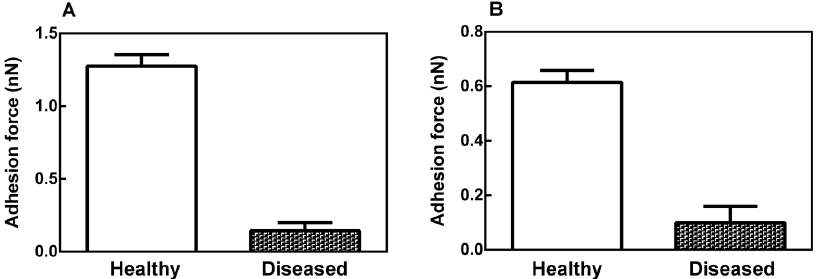
Figure 5. Average adhesion forces of the leaf midribs ( A ) and latex ( B ) of healthy and PMeV-infected papaya plants. The graphs show that the midribs and latex of the healthy plants have a greater adhesion force than those from the infected plants. The error bars represent the variations between biological replicates. The difference between means is statistically significant (Mann–Whitney test, p < 0.05).